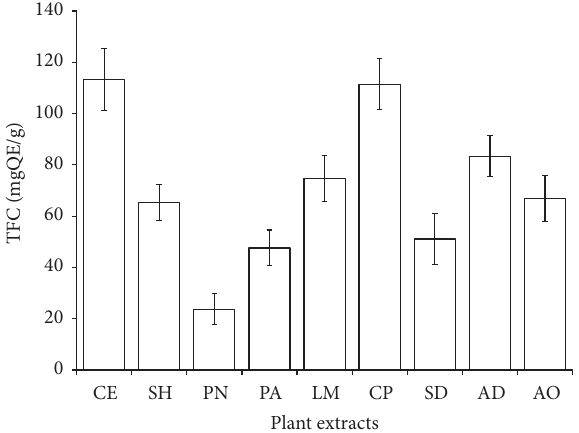
Figure 1: Total phenolic content (TPC) of selected antidiabetic plants used in southeast Nigeria. CE, Chlorophora excelsa ; CP, Ceiba pentandra , SH, Strophanthus hispidus , SD, Synsepalum dulcificum , PN, Picralima nitida , AD, Anthocleista djalonensis , PA, Persea americana ; AO, Anacardium occidentale; LM, Loranthus micranthus ; TAE, tannin acid equivalent.